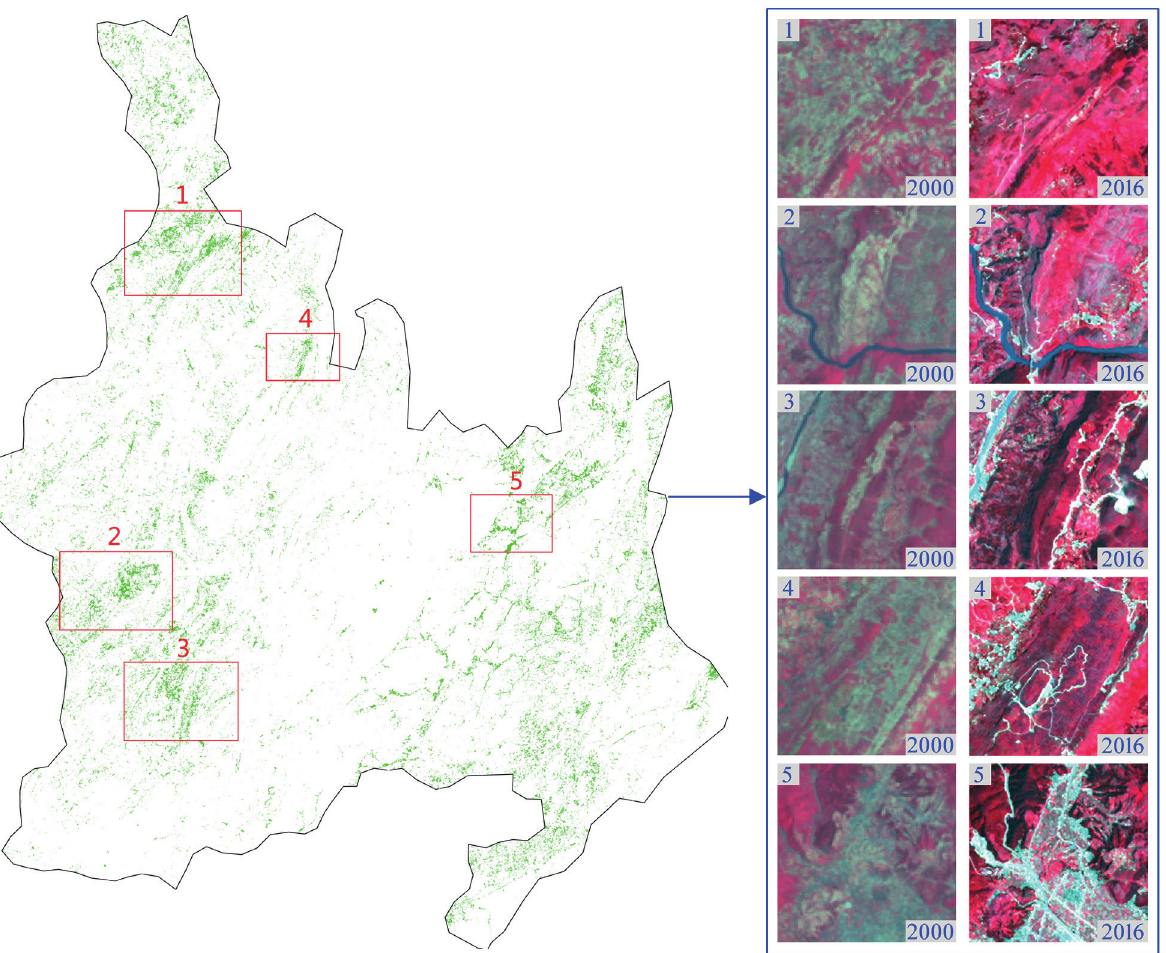
Figure 5 - New additional vegetation area and the part of contrast images of typical regions that was changed from 1 to 10 in 2000 and 2016,